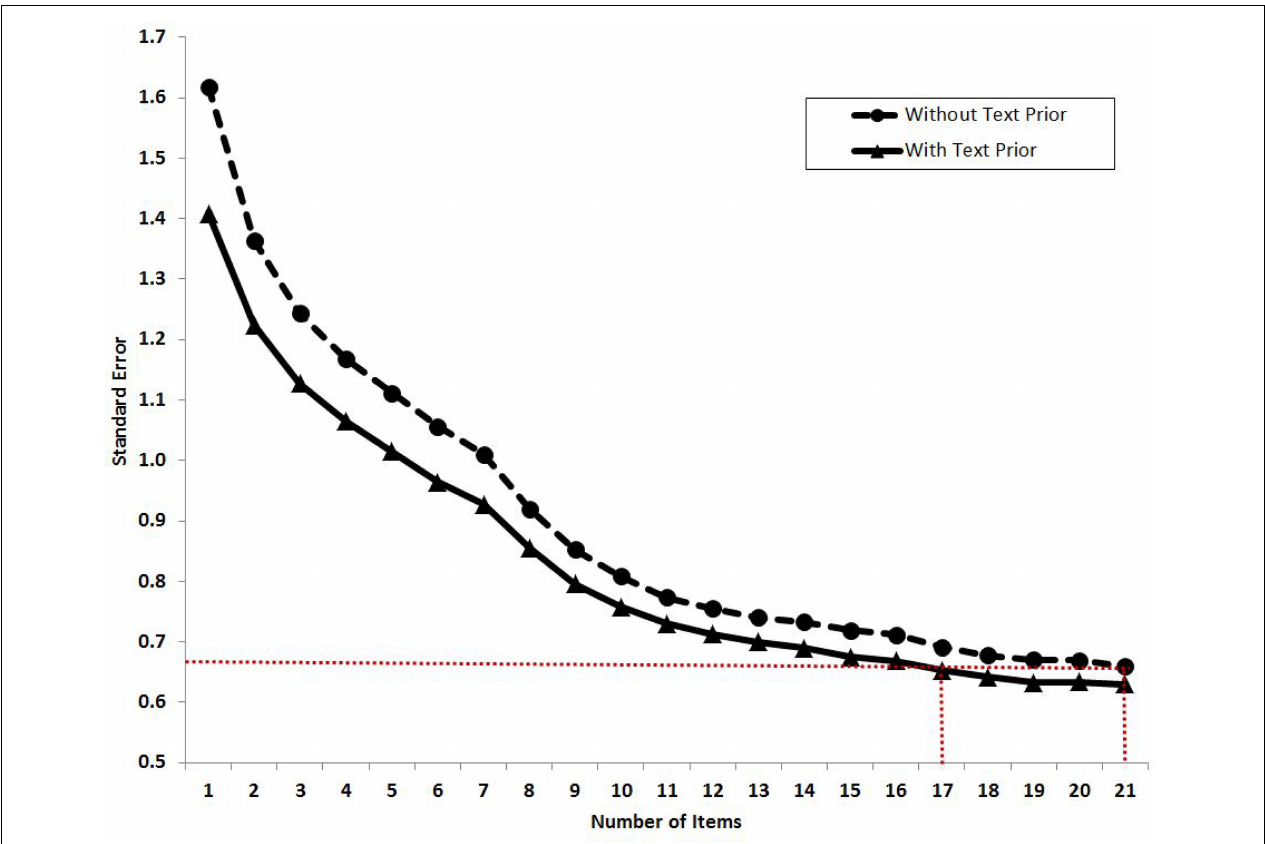
FIGURE 2 | The relationship between standard error of the estimate of θ and the increasing number of items with or without using text priors. The red dotted line indicates the standard error when using 21 items without text priors. It crosses the solid standard error curve at 17 items, meaning that by using the text priors, the test length can be shortened by four items. The order of items is ranked by a descending order of item information with the cutoff point that was derived in Figure 1